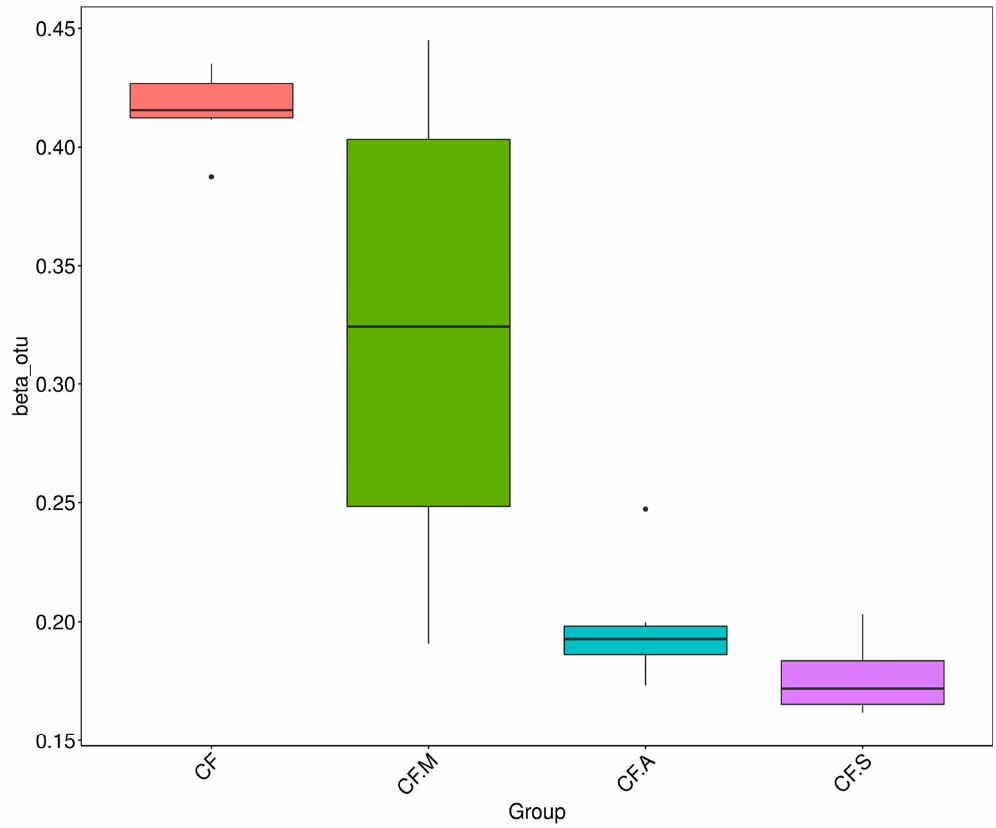
Figure 6. Boxplots of beta diversity based on the Bray–Curtis distances